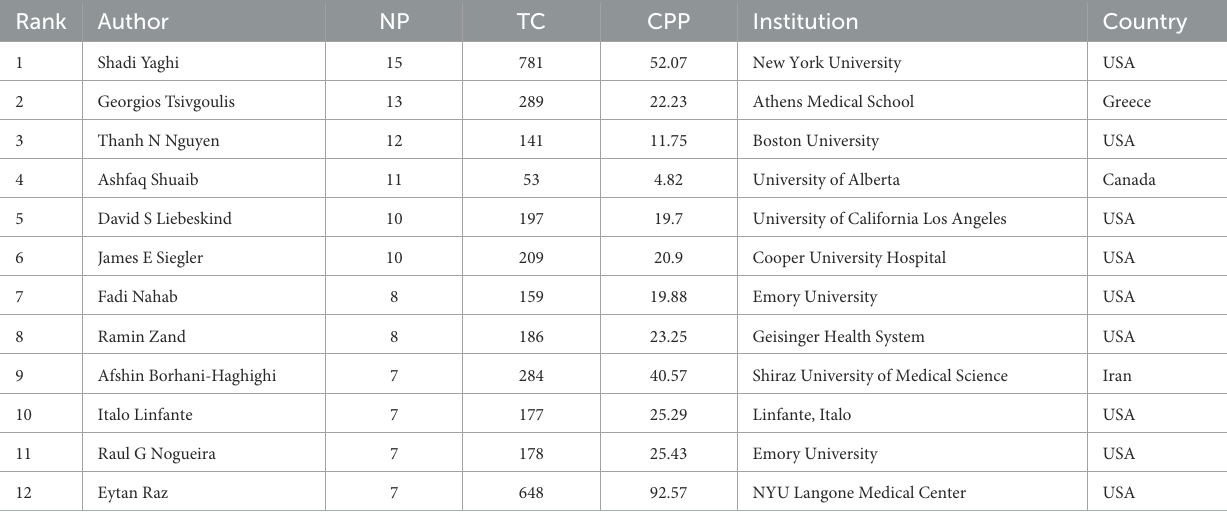
TABLE 3 The most prolific author in the field of COVID-19 and stroke research.